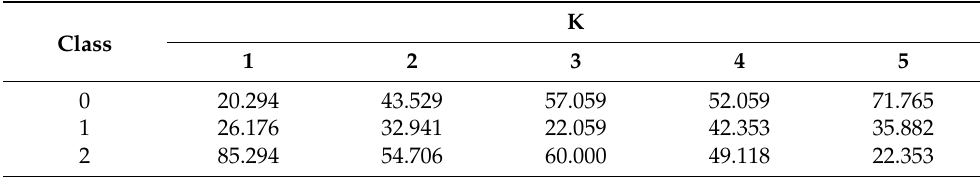
Table 6. Class accuracy comparison of number set K for key instances in the model. K takes values from 1 to 5, which denote different values of selected key instances.